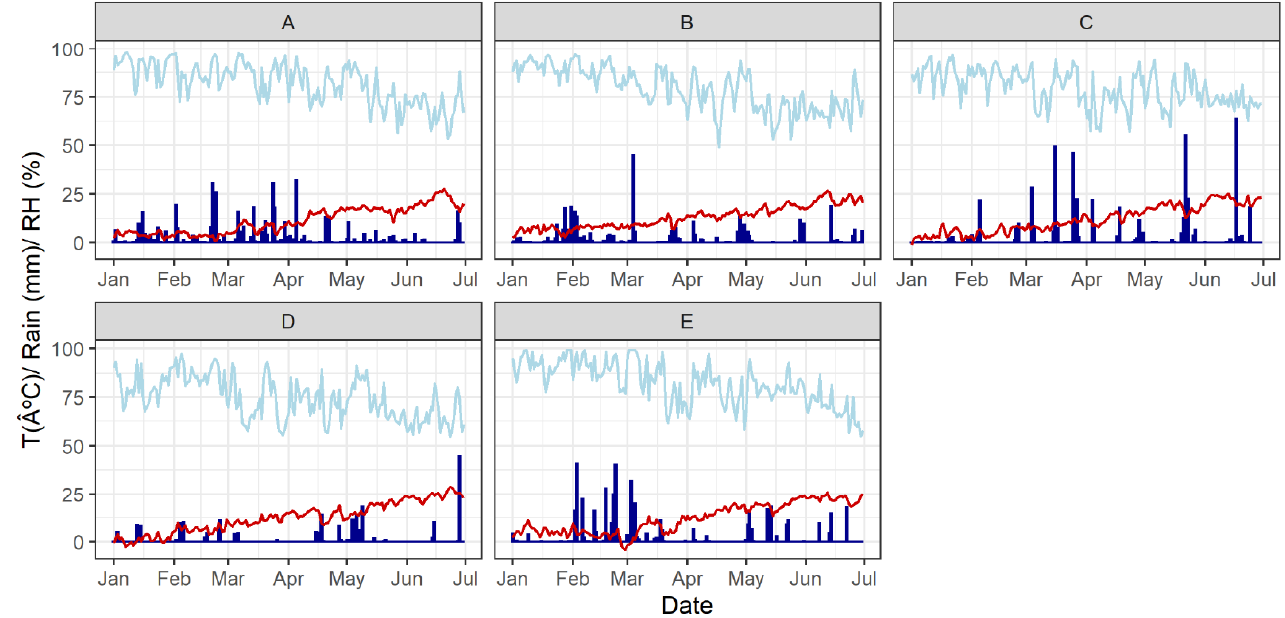
Figure 1. Weather conditions from January to July in the experimental field located at Ravenna, North Italy, in 2013 ( A ), 2014 ( B ), and 2015 ( C ) for EXP1, and in 2017 ( D ) and 2018 ( E ) for EXP2. The figure shows daily values of temperature (T; red line; in degrees Celsius), relative humidity (RH; light blue line; in percentage), and rain (blue bars; in millimetres).